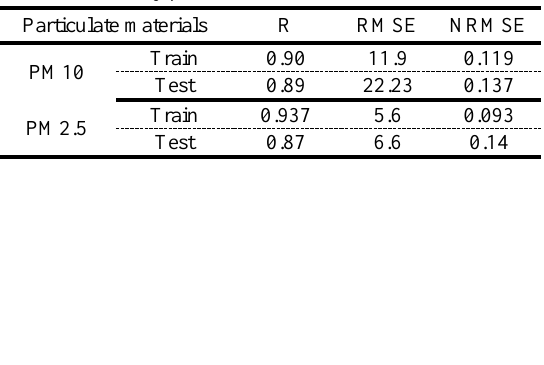
Table4. accuracy